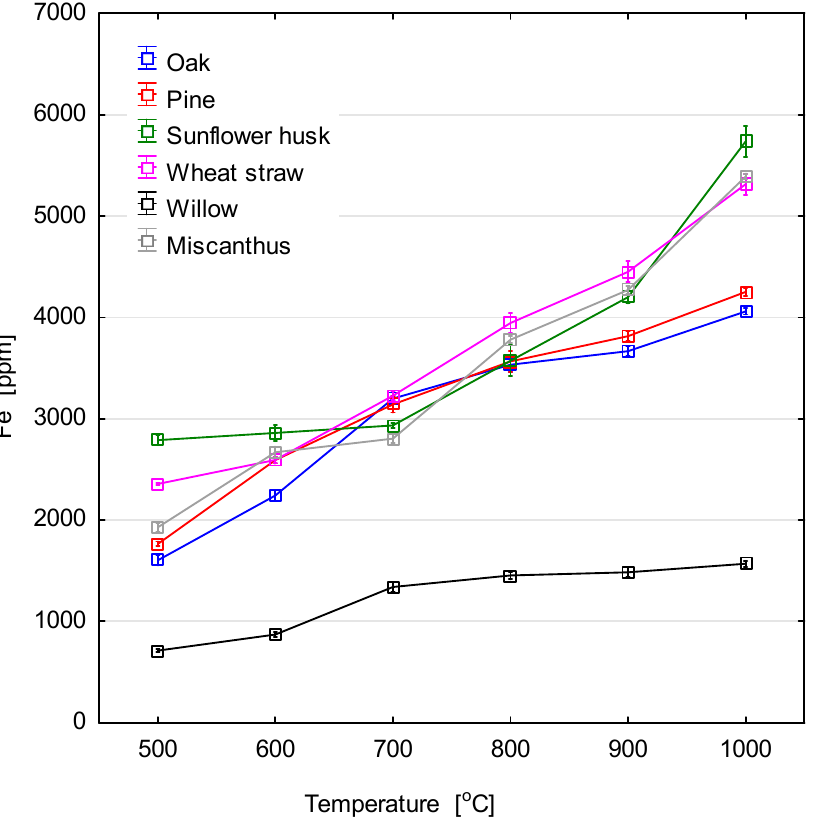
Figure 8. Changes in Fe content in the examined biomass depending on ash-forming temperature.